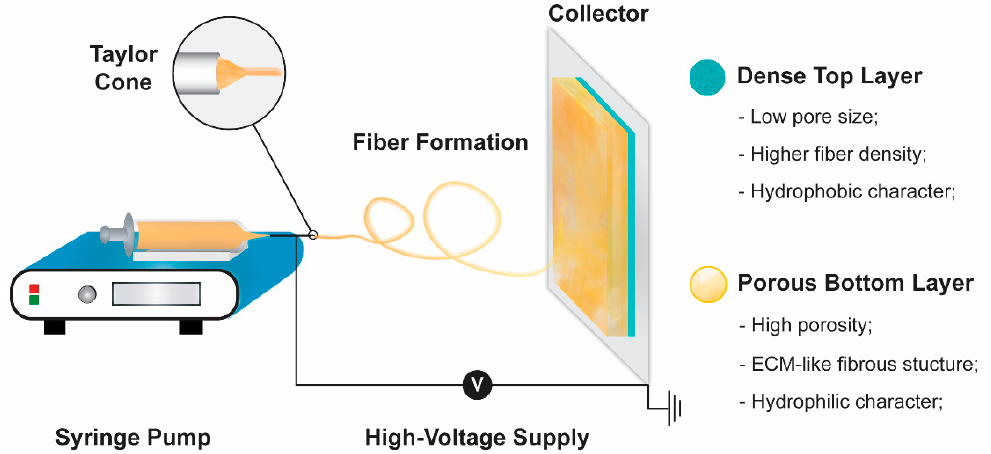
Figure 2. Illustration of a conventional electrospinning apparatus used in the production of an asymmetric electrospun membrane. The physical properties of each layer of the produced membrane are also presented.